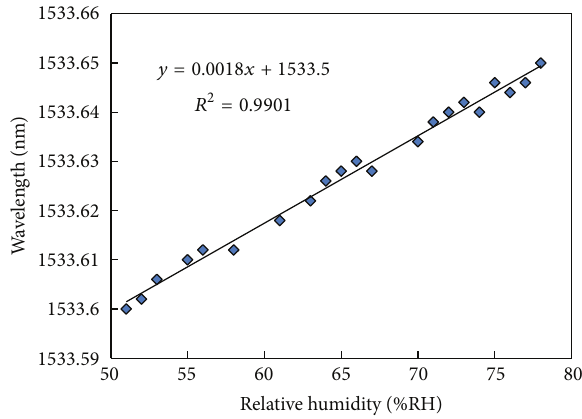
Figure 5: Relationship between RH and resonant wavelength 𝐴 .